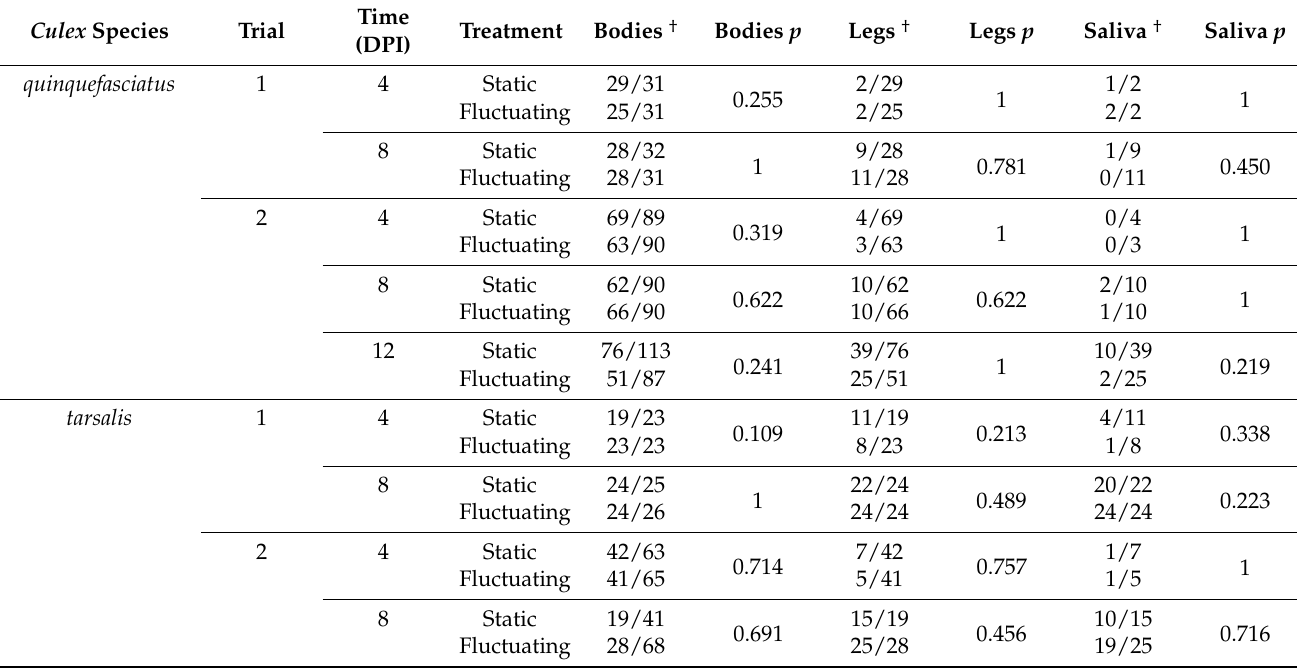
Legs p Saliva p